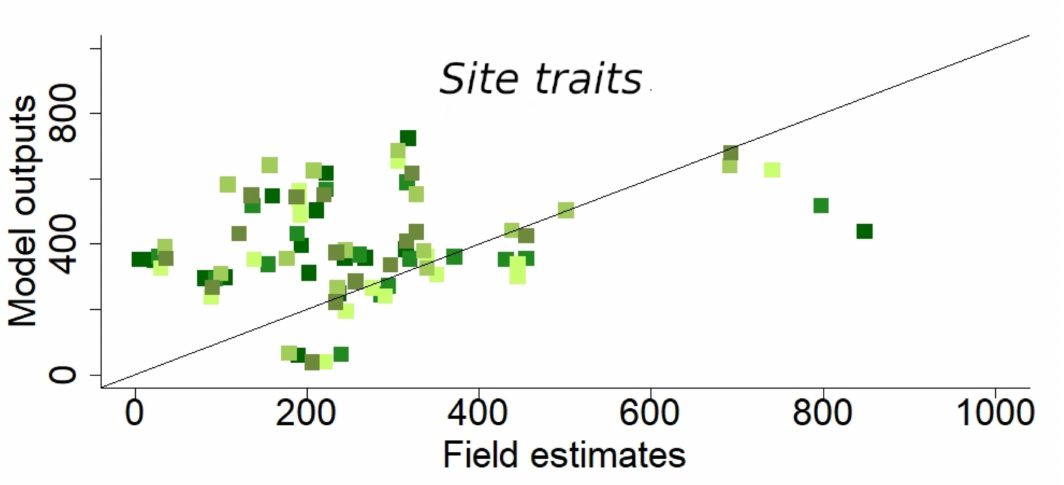
Figure 9. Comparison of net primary productivity (g C/sq. m/yr) model outputs for years 2012 to 2016 with sites estimates, when using PFT traits , field mean traits , computed traits or site traits .